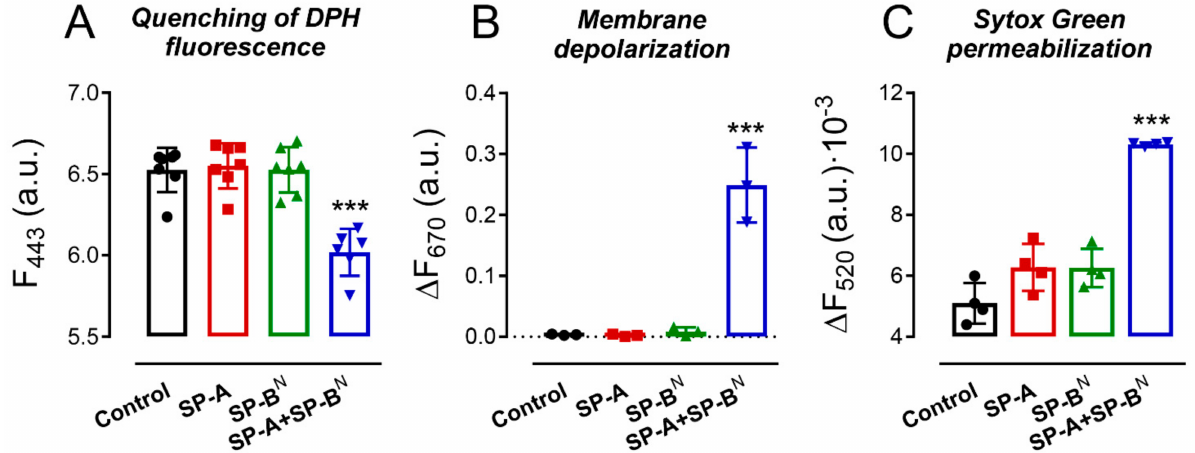
Figure 2. The SP-A/SP-B N complex, but not the proteins alone, altered the integrity of the outer and cytoplasmic membranes of K. pneumoniae . Bacteria were incubated with SP-A and/or SP-B N in the presence of 1,6-diphenyl-1,3,5-hexatriene (DPH) ( A ), 3,3 (cid:48) -dipropylthiadicarbocyanine iodide (DiSC 3 -(5)) ( B ), or Sytox Green ( C ), and the change in the fluorescence of the dyes was recorded as a function of time. Data shown in ( A ) correspond to the fluorescence of DPH after treatment with the proteins for 30 min, whereas ( B , C ) show the difference in the fluorescence of the dyes at t = 30 min and t = 0 min. The experiments were performed at 37 ◦ C. Protein concentration: SP-A 154 nM (100 µ g/mL) and SP-B N 1.25 µ M (10 µ g/mL). The results are the mean ± SD of at least three experiments, each one triplicated. A p -value < 0.001 was obtained for the overall one-way ANOVA (Bonferroni-corrected p -value: *** p < 0.001 when compared to the